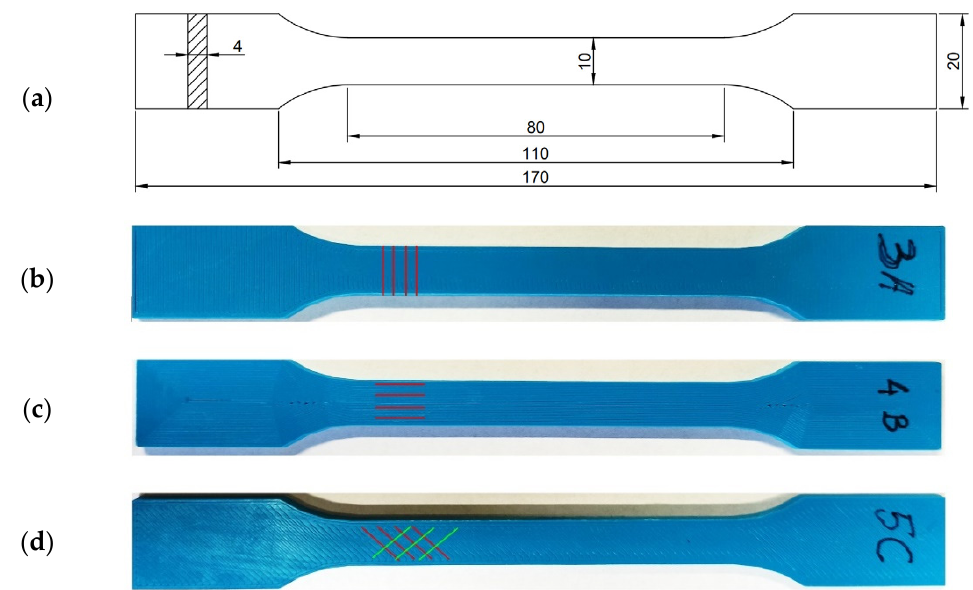
Figure 3. ( a ) The geometry of a PLA-IMPACT material specimen for a static tensile test and specimens printed with ( b ) transverse, ( c ) parallel, and ( d ) crosshatched raster.